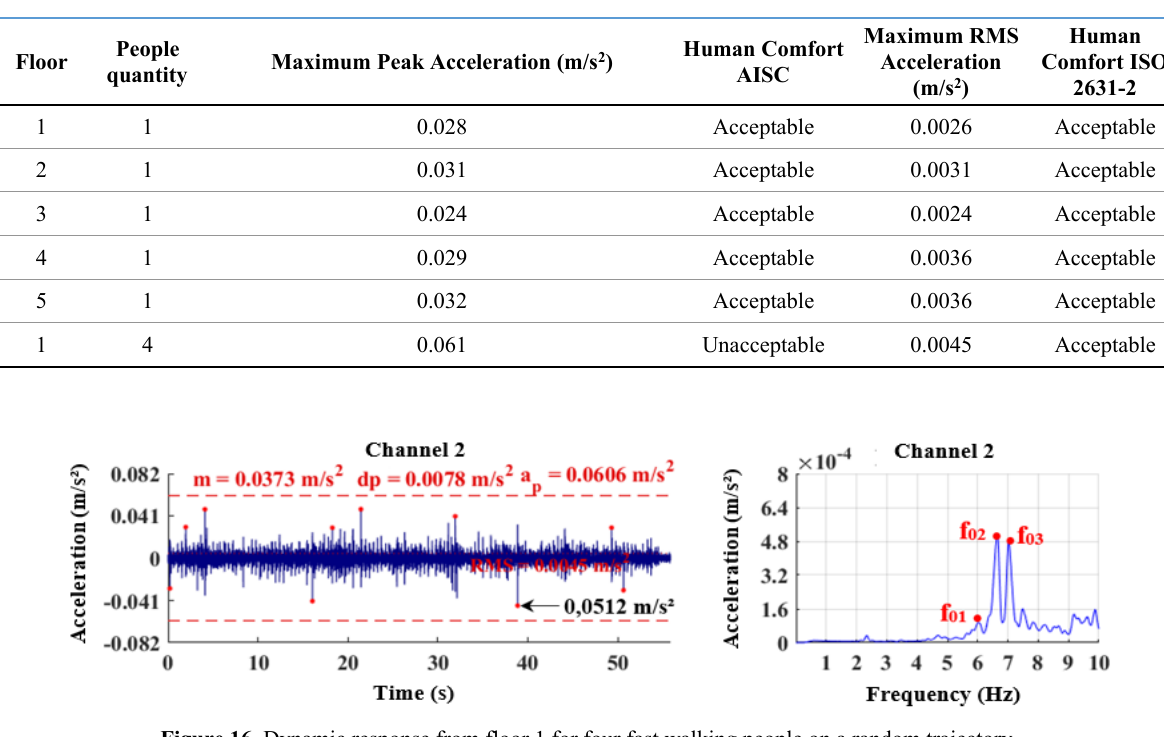
Table 3. Comparison of the accelerations obtained on the five floors with normative limits.